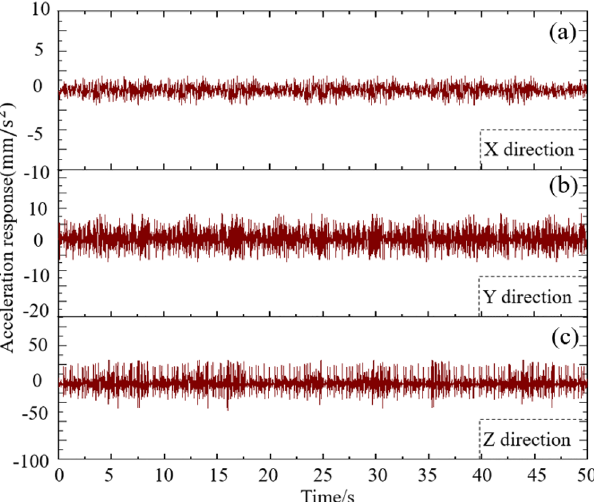
Figure 11. Flow-induced acceleration diagram of radial gate.